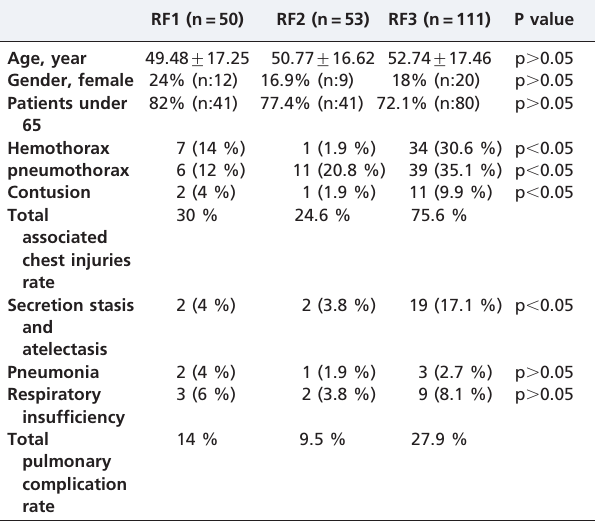
Table 1 - The demographic and clinical characteristics of the patients by group.